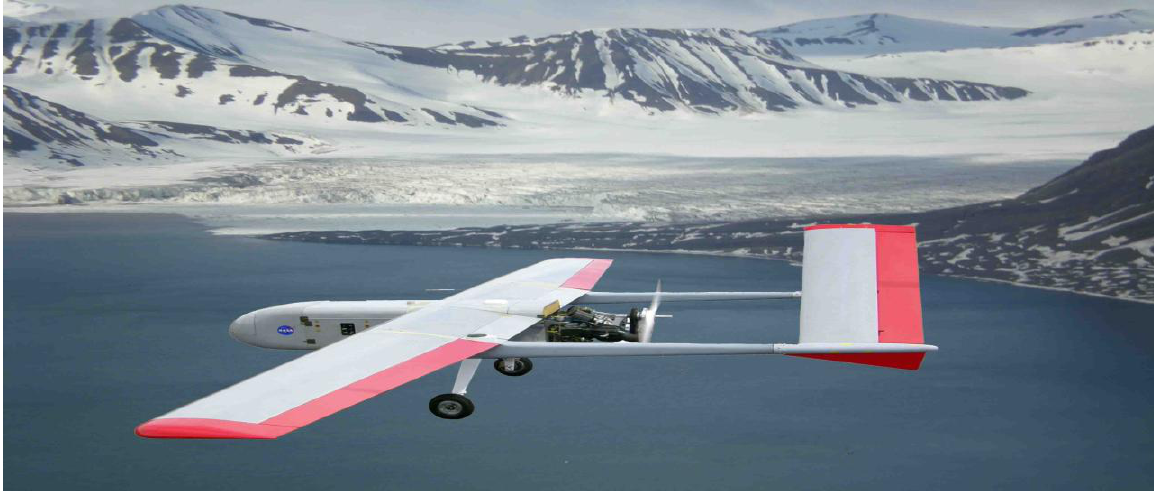
Figure 9. The NASA SIERRA, shown flying near Svalbard, Norway, 2009. Image courtesy